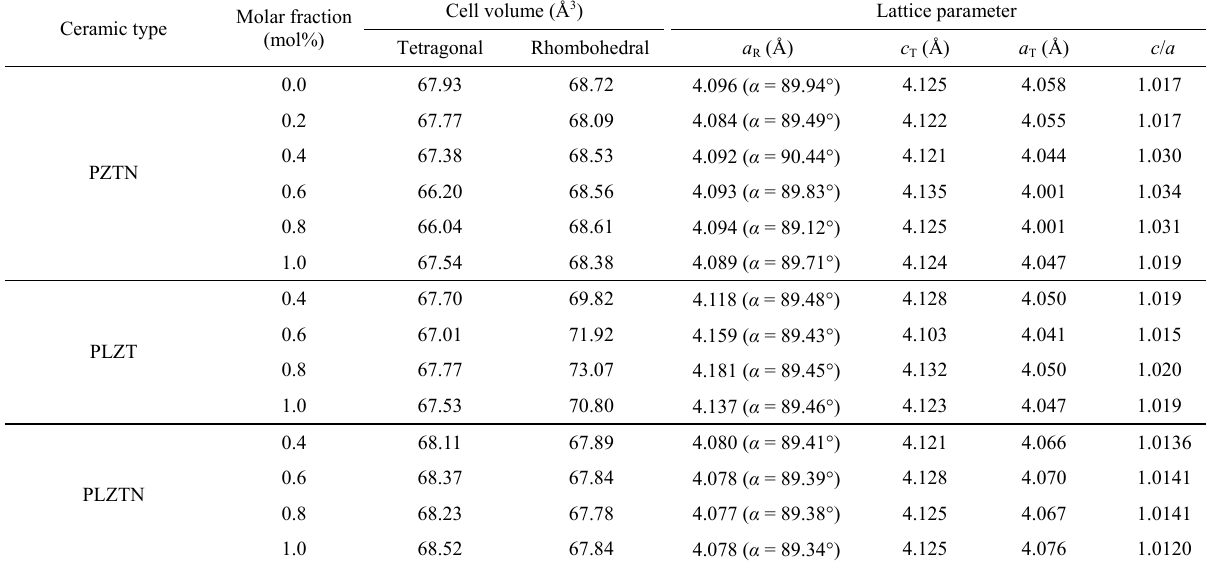
Table 2 Lattice parameters and cell volume for the PZT 53/47 doped at different concentration of La 3+ and Nb 5+ , at room temperature